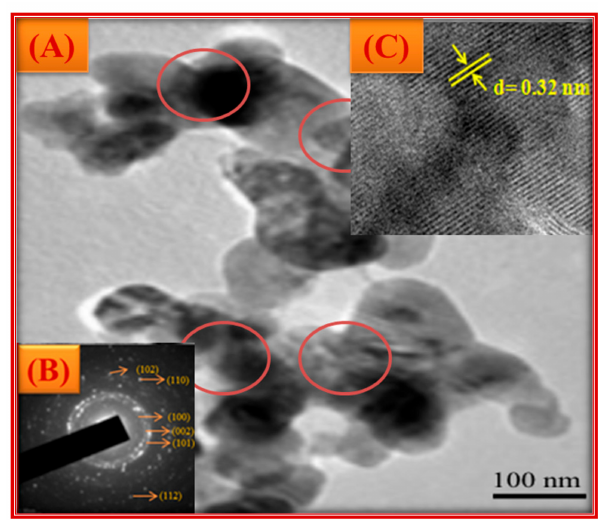
Figure 5. TEM image of ZnO(c) ( A ); SAED pattern of ZnO NPs ( B ); High-resolution transmission electron microscopy (HRTEM) with d-spacing ( C ).